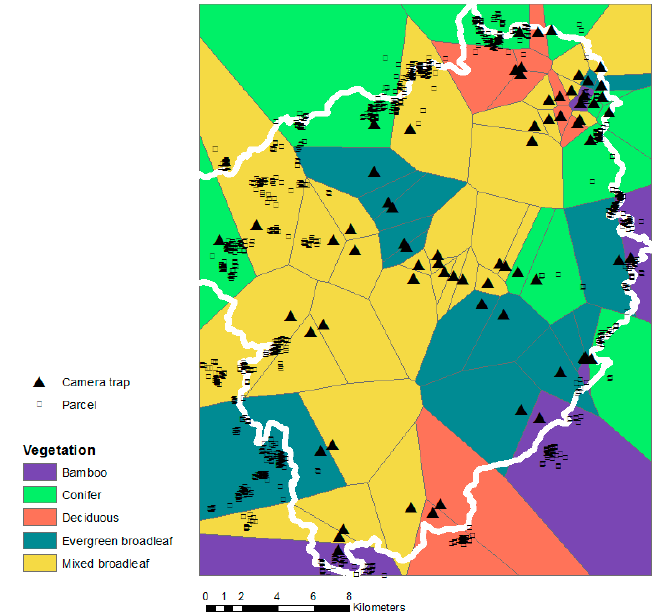
Figure 3. Map of study site, camera traps, parcels, and vegetation types.